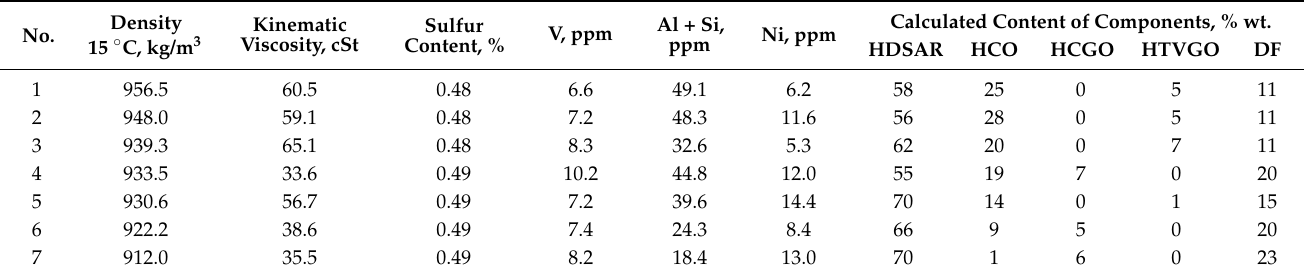
Table 4. Averaged BP batches and results of modeling their composition